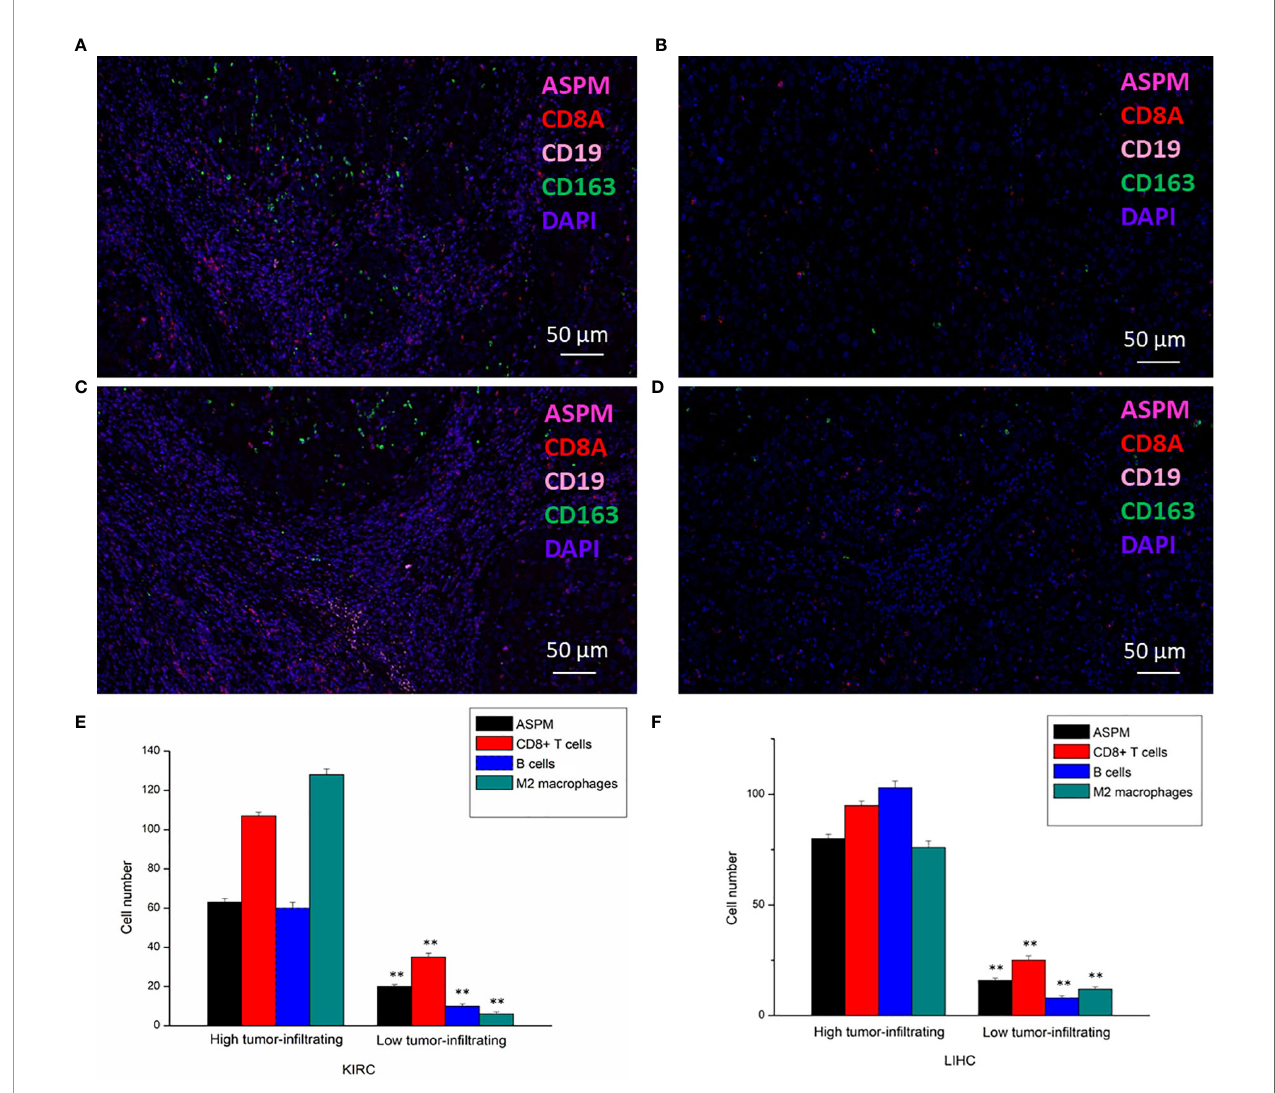
FIGURE 8 | Detection of tumor-in fi ltrating levels of CD8 + T cells, B cells, and M2 macrophages in KIRC and LIHC using multiplex quantitative immuno fl uorescence. 20 diagnosed cases of KIRC and 20 diagnosed cases of LIHC samples for ultiplex quantitative immuno fl uorescence. Representative fl uorescence images showing the detection of immune cells samples by simultaneous staining of DAPI, ASPM (rose red channel), CD8A (red channel), CD19 (pink channel), and CD163 (green channel) in KIRC (A, B) and LIHC (C, D) . CD8 + T cells marker: CD8A; B cells marker: CD19; M2 macrophages marker: CD163. (E, F) : Immune cell in fi ltration level at high or low expression of ASPM in KIRC and LIHC. **p <